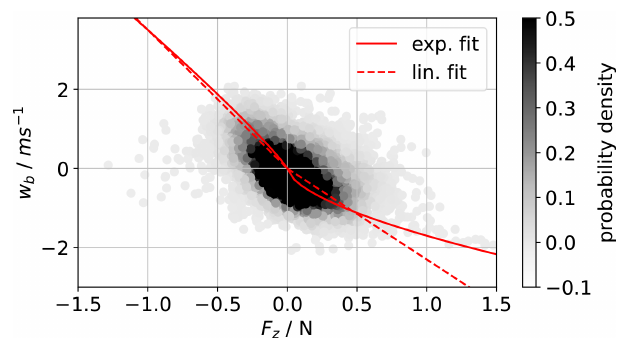
Figure 6. Scatterplot of vertical wind of the sonic anemometer ver- sus the acting force on the UAS in the body frame. The greyscale represents the probability of occurrence in the dataset. The solid red line shows the estimated calibration curve. The dashed red line shows a linear fit for comparison.